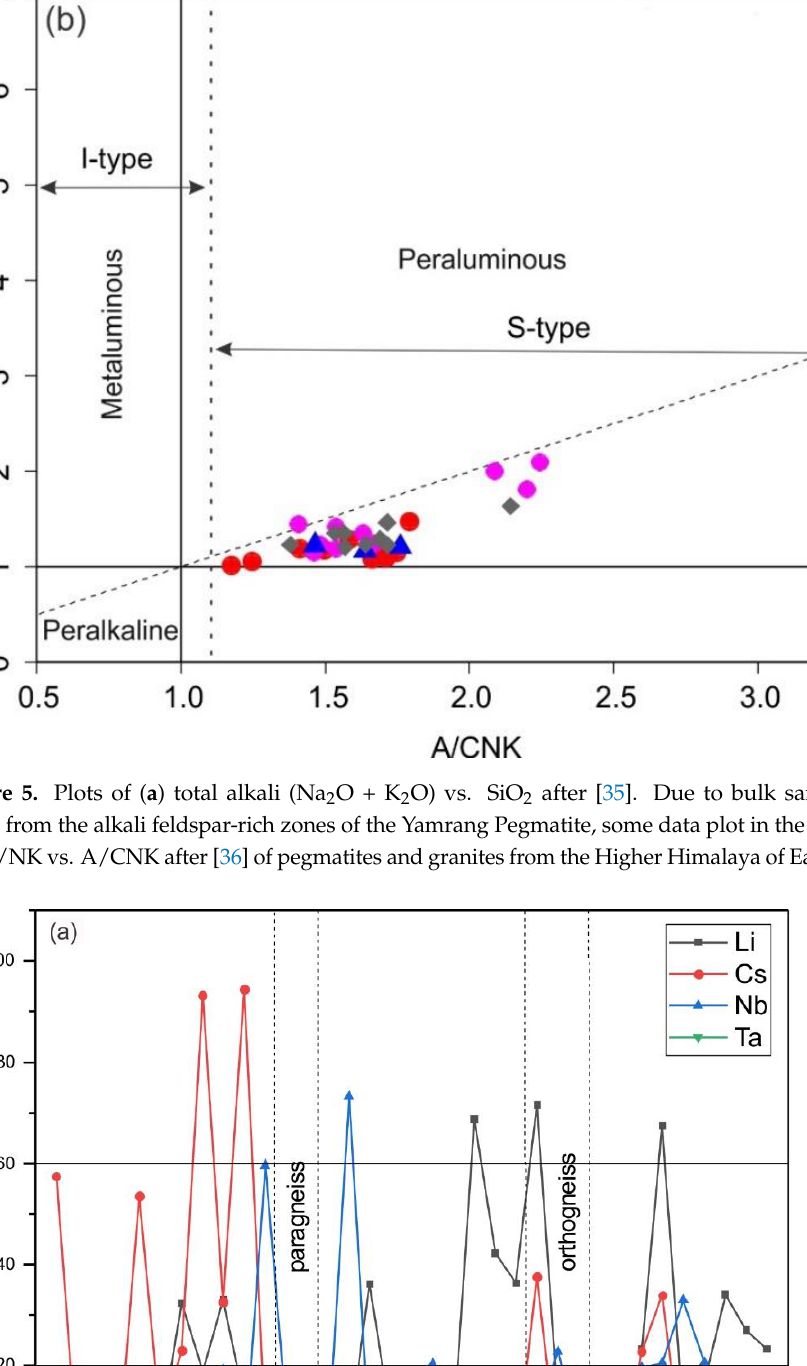
Figure 6. Concentration profiles of ( a ) Li-, Cs-, Nb-, Ta-; ( b ) Be- in pegmatites, gneiss, and granites from Eastern Nepal, Higher Himalaya.